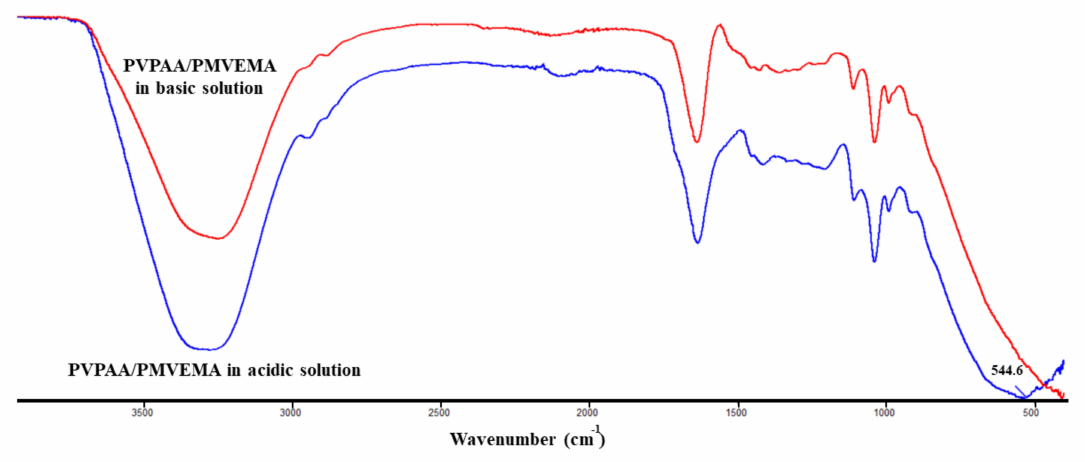
Figure 6. FT-IR Spectra of the PVPAA/ PMVEMA in acidic and basic